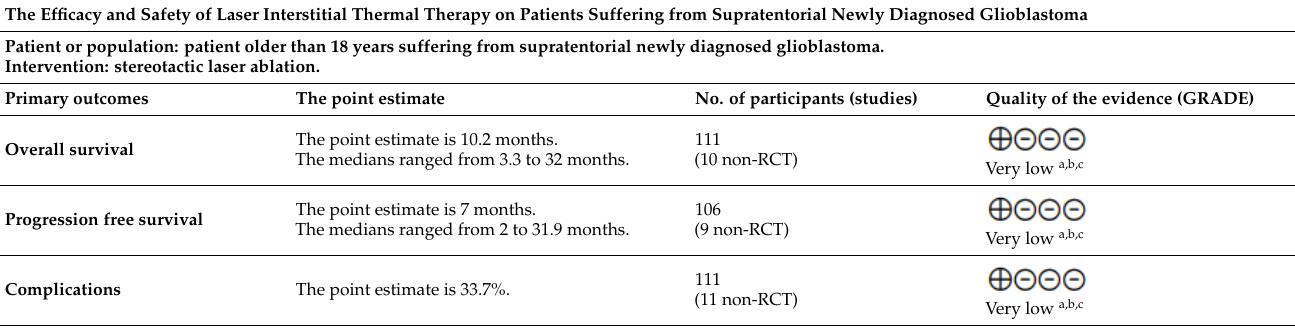
Table 2. GRADE assessment of quality of evidence.